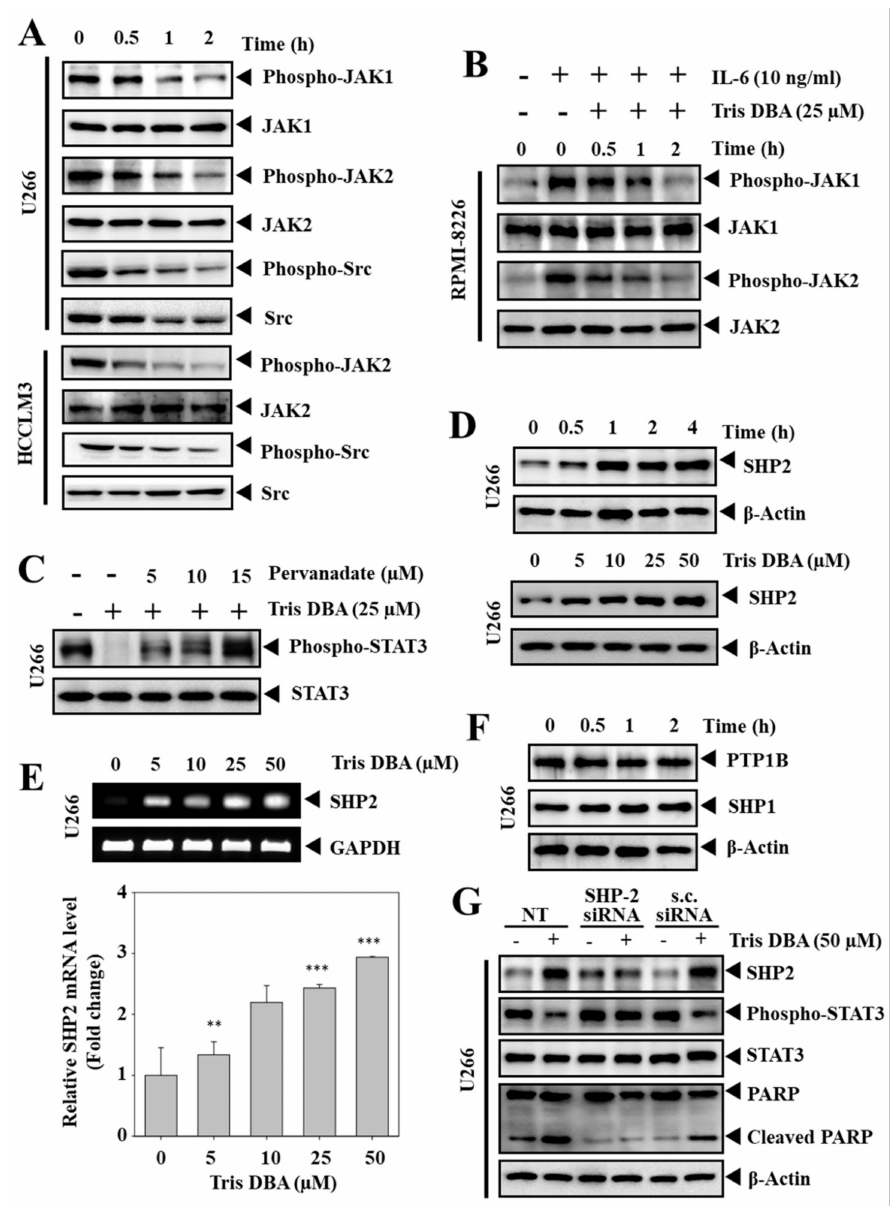
Figure 4. Tris DBA suppresses upstream proteins and enhances the expression of SHP2. ( A ) U266 and HCCLM3 cells were exposed to Tris DBA (25 and 50 µ M respectively) and cell lysates were used to analyze phosphorylated NRTKs and total proteins expression. ( B ) RPMI-8226 cells were